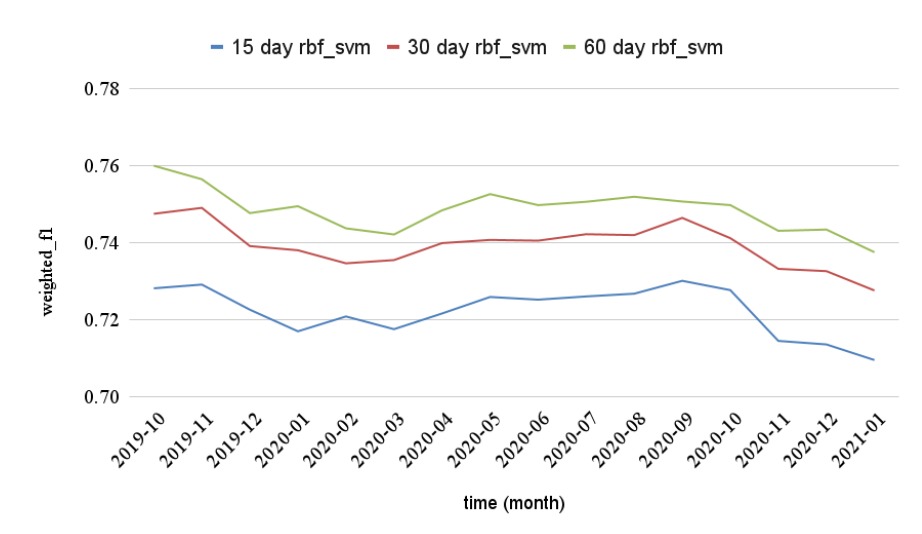
Figure 6. Comparison of best models for each scenario (initial training window of 15, 30, and 60 days), averaged by month, using features extracted from fake